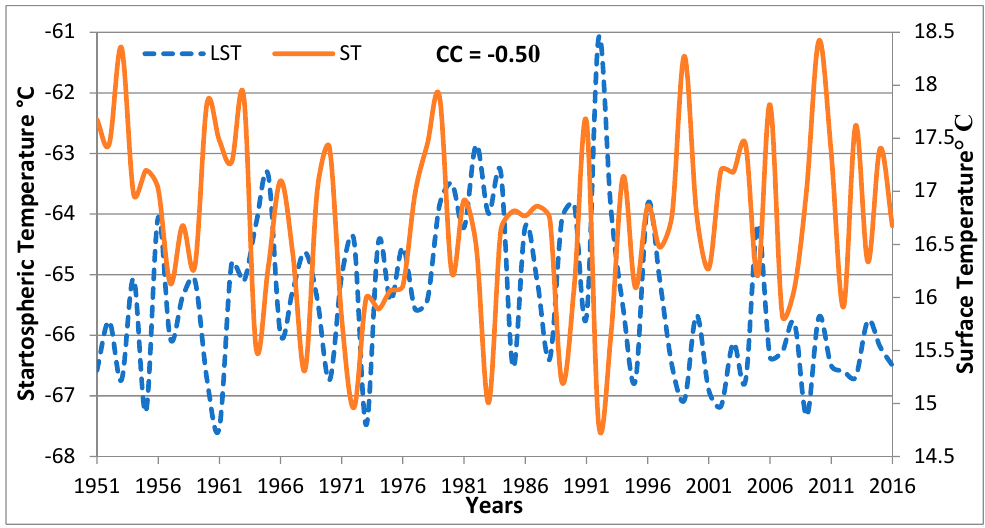
Figure 6. The distribution pattern of the ST and LST time series. The CC represents the correlation coefficient at zero lag, which is significant at the 95% confidence